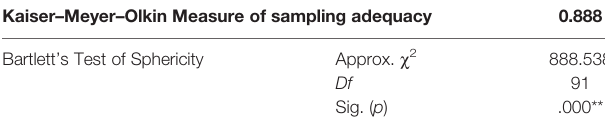
TABLE 2 | KMO and Bartlett ’ s Test ( N =